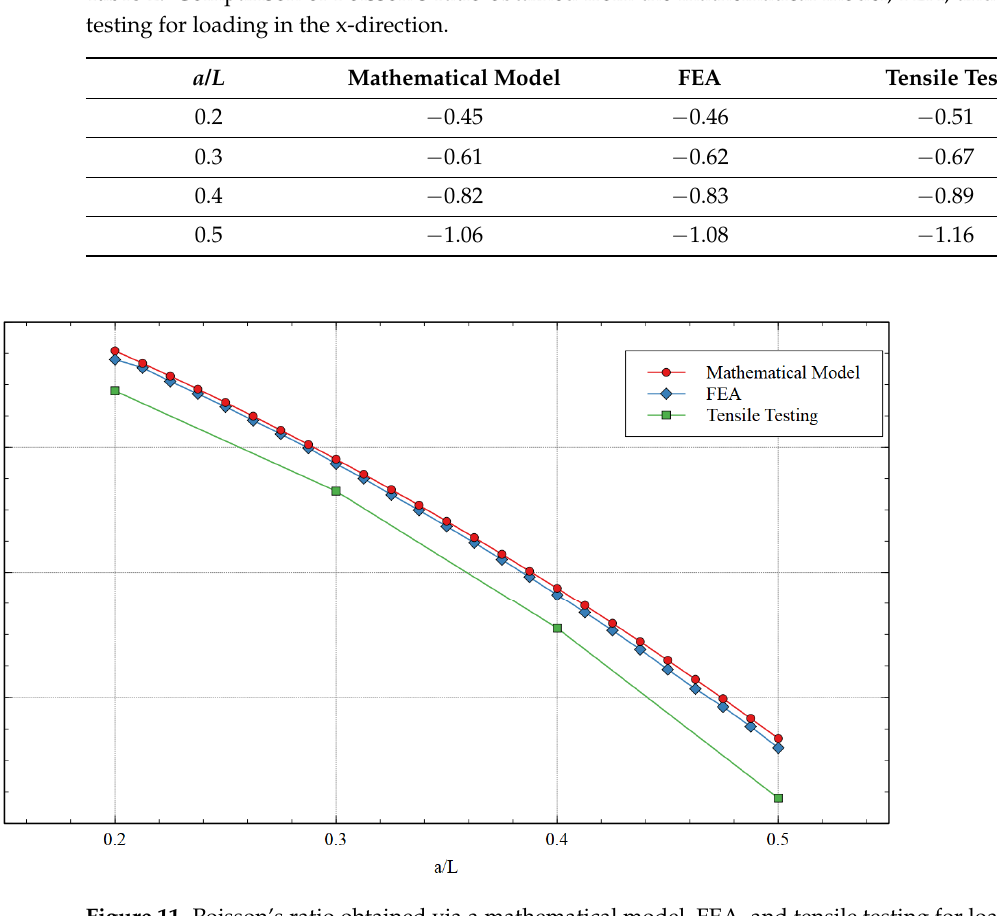
Table 2. Comparison of Poisson’s ratio obtained from the mathematical model, FEA, and tensile